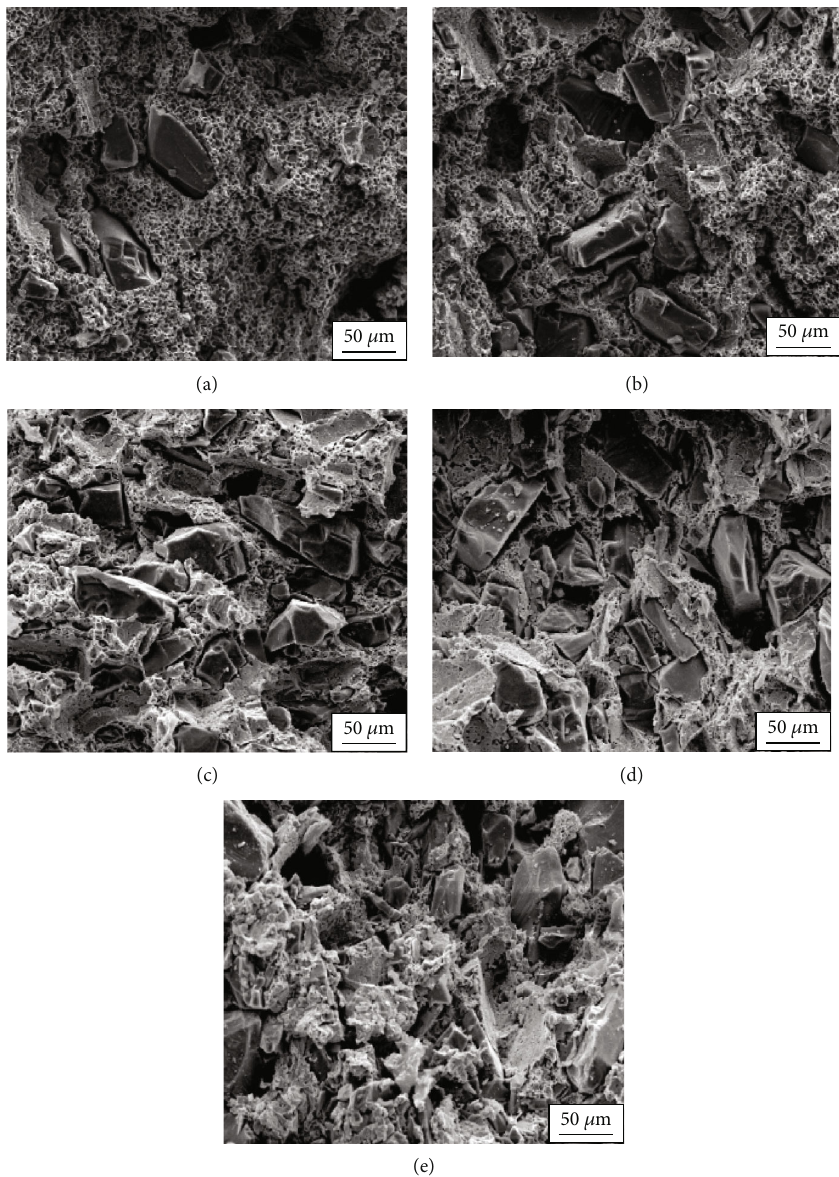
Figure 6: Fracture surface of SiC@Cu/Cu composites with di ff erent SiC@Cu fractions: (a – e) SiC@Cu fraction with 10%, 20%, 30%, 40%, and 50%. Table 1: Vickers hardness and relative density of the SiC@Cu/Cu composite.